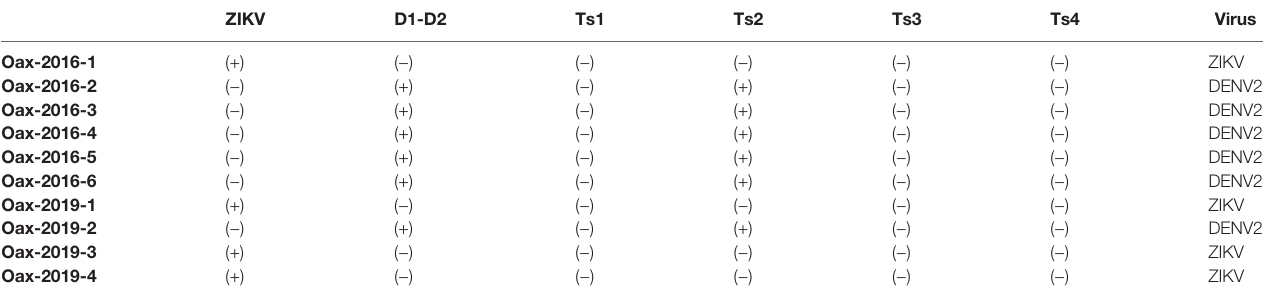
TABLE 2 | Species and serotypes of Flavivirus